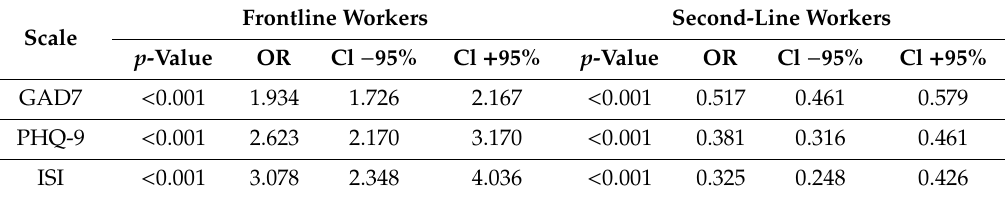
Table 3. Multivariable logistic regression model among frontline and second-line workers. Frontline Workers Second-Line Workers Scale p -Value OR Cl − 95% Cl + 95% p -Value OR Cl − 95% Cl + 95% GAD7